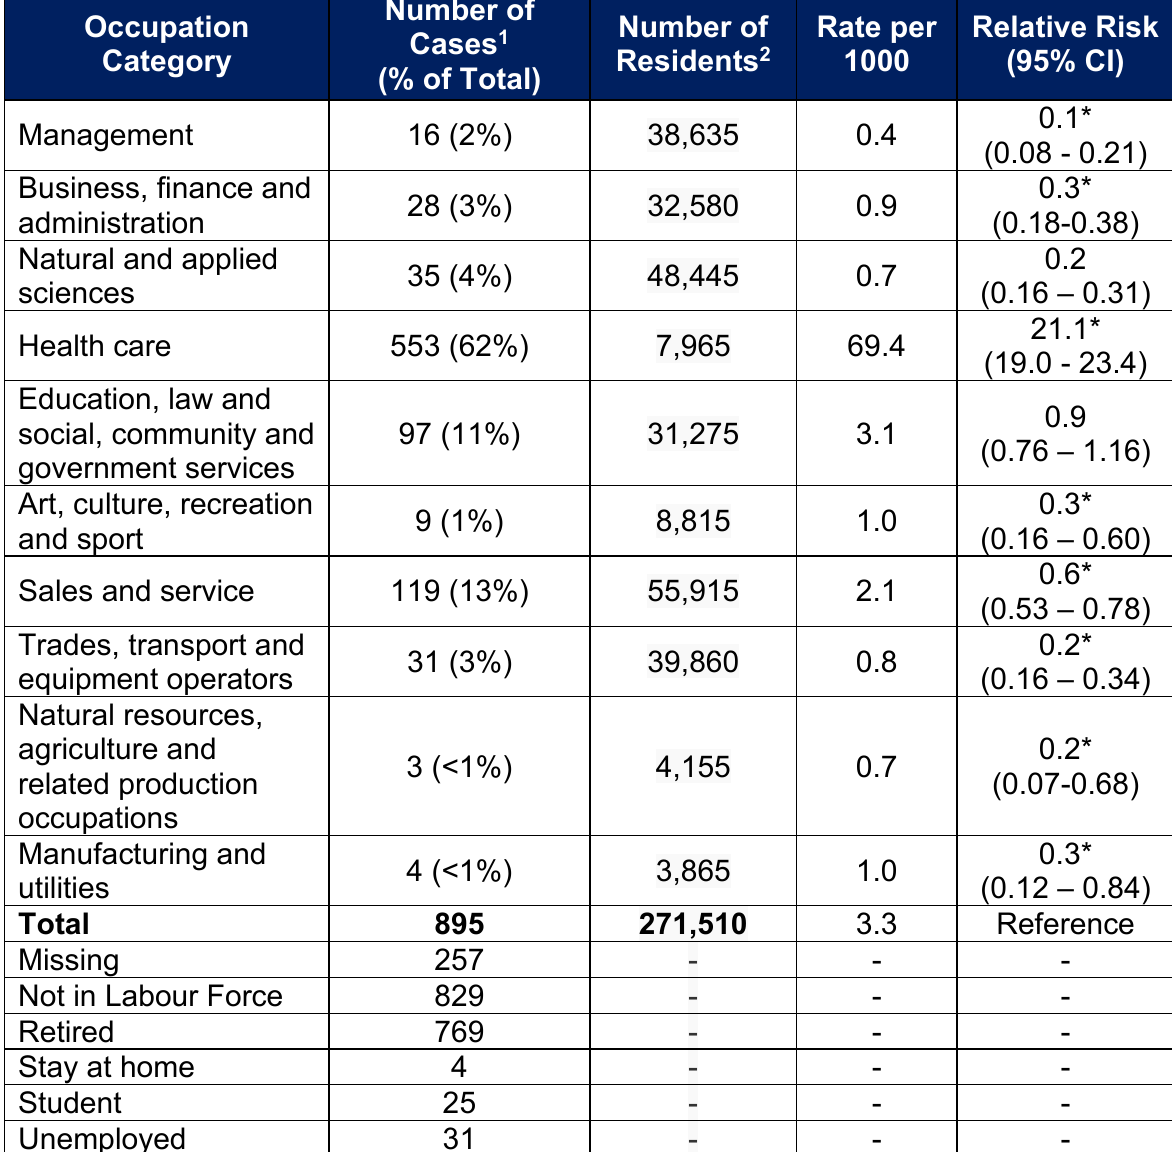
Table 5. Occupations reported by confirmed COVID-19 cases up to June 14, 2020, compared to reported occupations, Ottawa workers ages 15 and